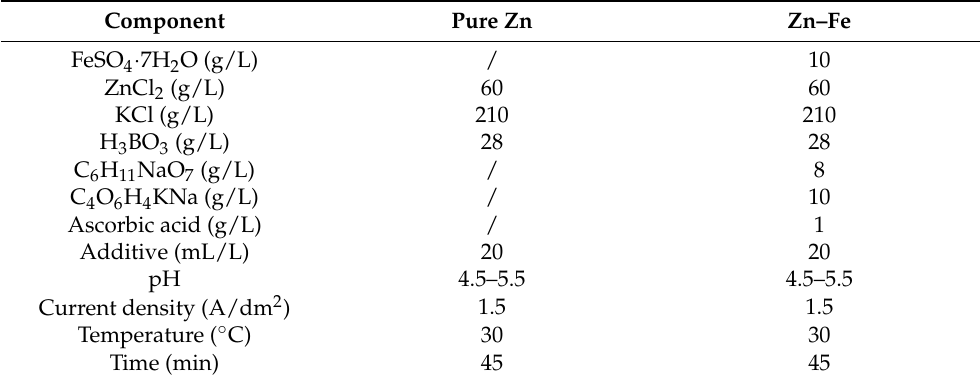
Table 1. Bath composition and electrodeposition parameters.